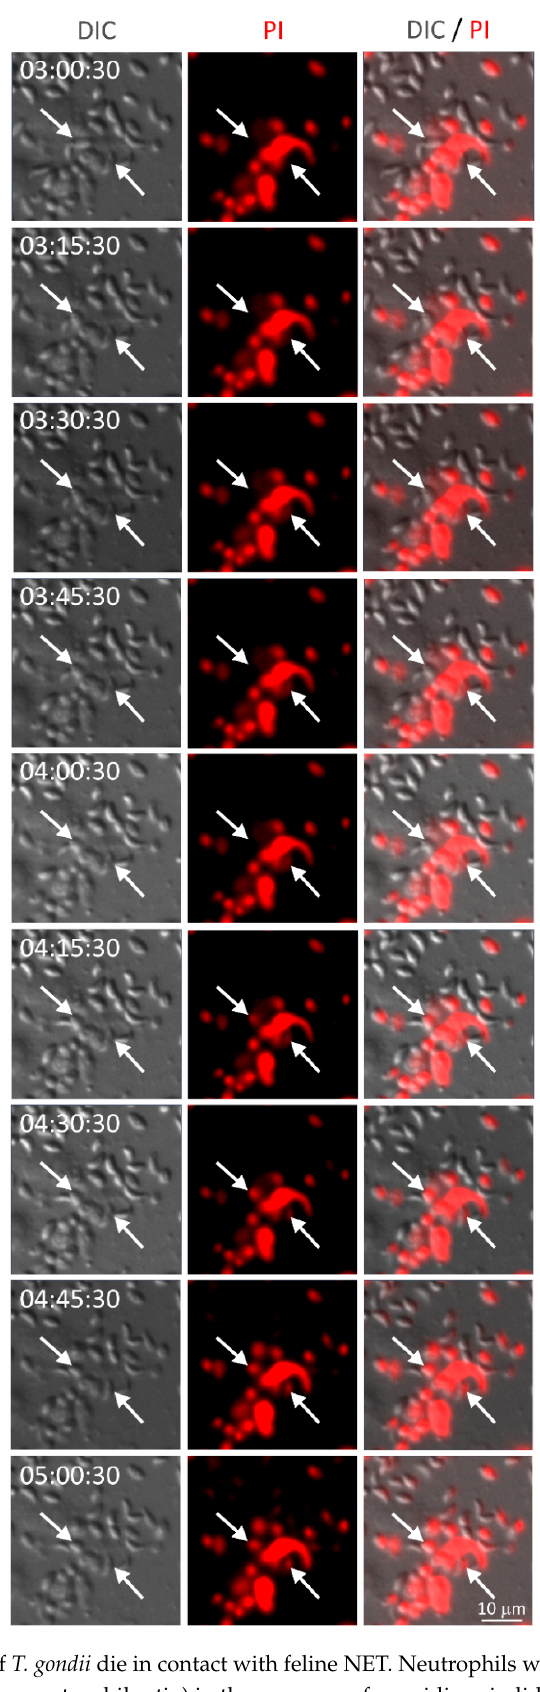
Figure 7. Tachyzoites of T. gondii die in contact with feline NET. Neutrophils were stimulated with RH tachyzoites (5:1 parasites:neutrophil ratio) in the presence of propidium iodide (PI) and images were recorded during the time. Arrows point to two parasites dying after contact with NET. DIC = differential interference contrast.